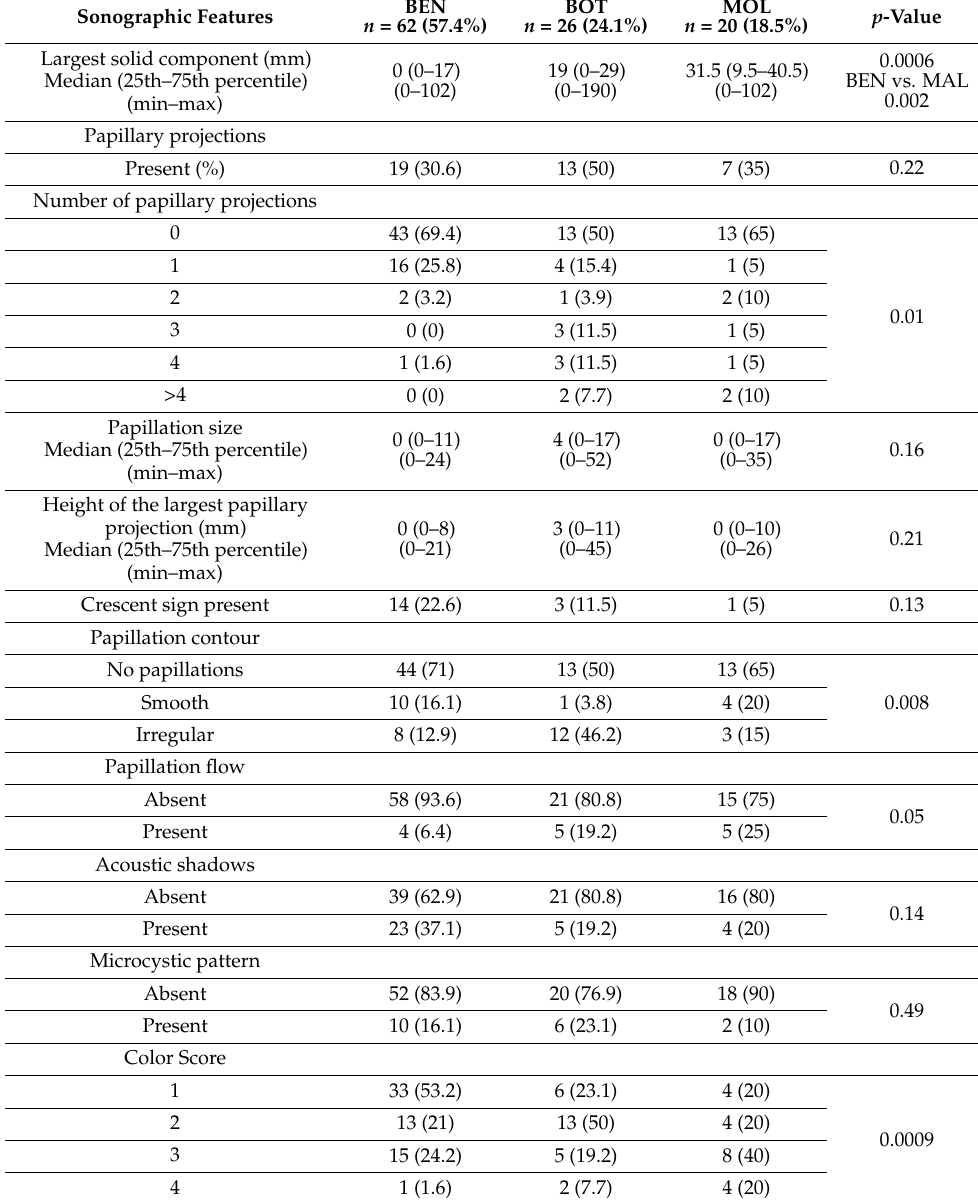
Table 3. Comparison of selected sonographic features of complex adnexal